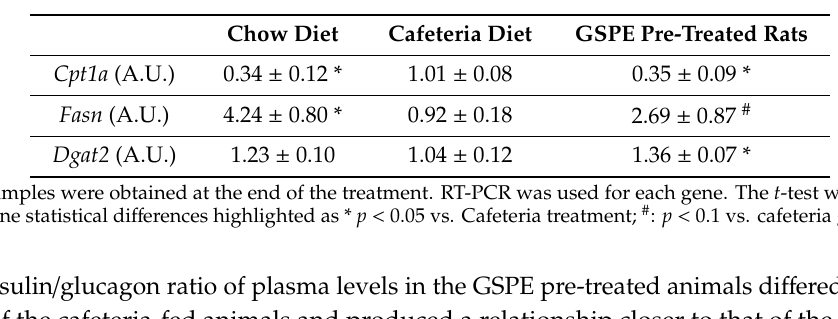
Table 3. E ff ects of GSPE on liver seventeen weeks after treatment (long cafeteria